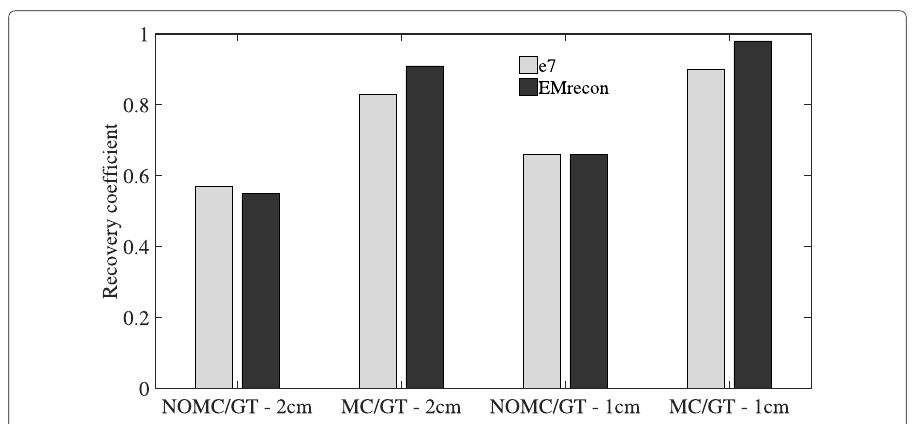
Fig. 5 Recovery coefficients of the lesion evaluation for the phantom